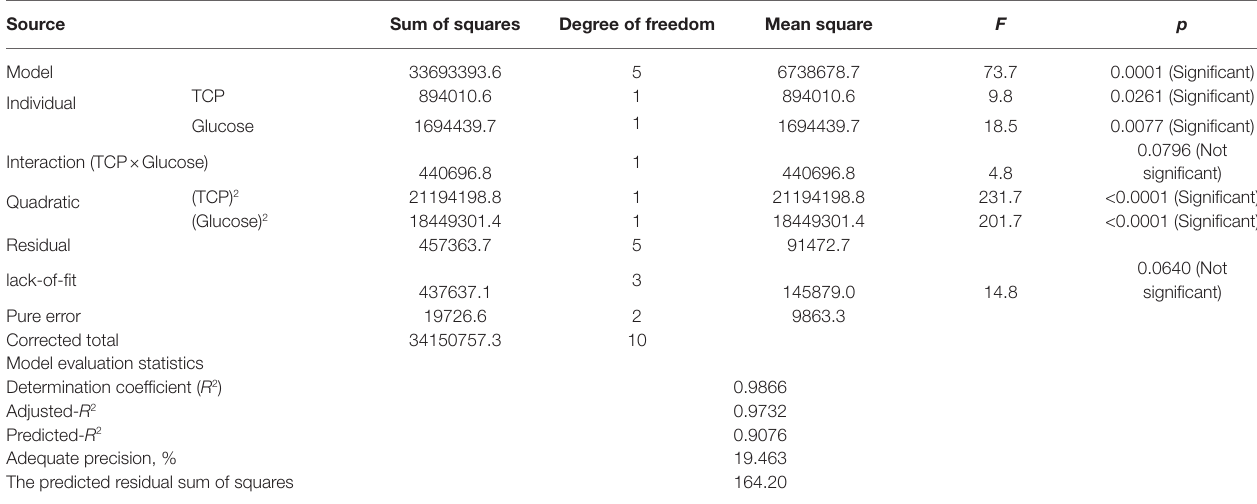
TABLE 3 | ANOVA of CCD matrix of CA production on the PNR-based medium based supplemented with TCP and glucose by Trichoderma longibrachiatum WKA55. Source